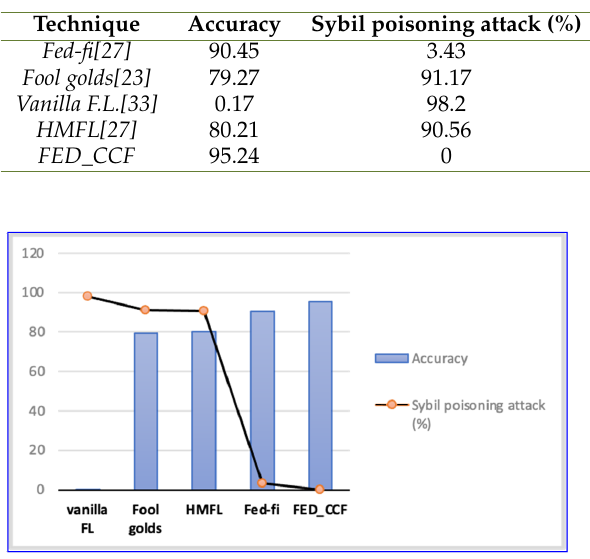
Fig. 7. Performance index of Sybil poisoning attacks detection